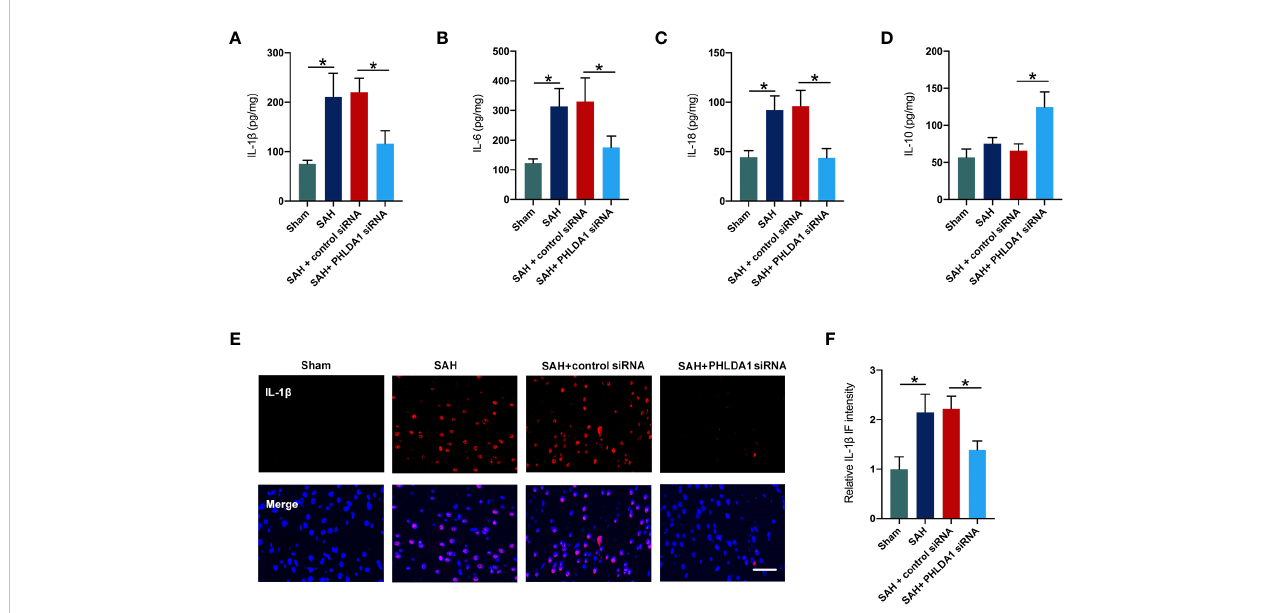
FIGURE 3 PHLDA1 de fi ciency mitigated in fl ammatory insults after SAH. ELISA analysis of IL-1 b (A) , IL-6 (B) , IL-18 (C) , and IL-10 (D) expressions (n = 6 per group). (E) Representative immuno fl uorescence images of IL-1 b staining in temporal cortex. (F) Quanti fi cation of IL-1 b immunoactivities (n = 6 per group). * P < 0.05. Scale bar=50 m m. Data are expressed as mean ± S.D.